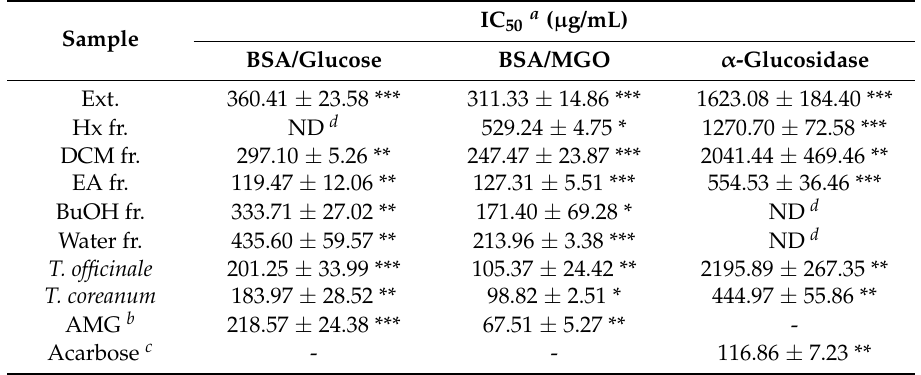
Table 1. IC 50 of the extracts and fractions from T. coreanum on advanced glycation end-product (AGE) formation in BSA/glucose and BSA/ MGO systems and α -glucosidase inhibitory activities.